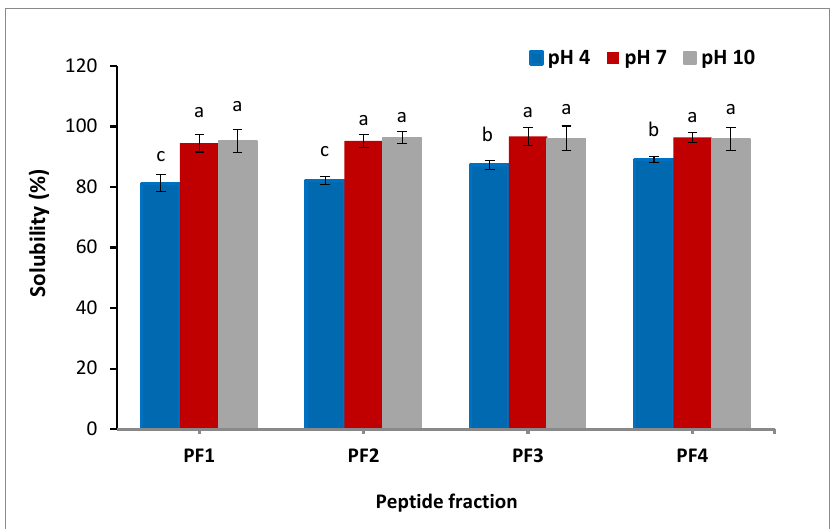
Figure 1. Solubility of the isolated peptide fractions at pH 4.0, 7.0, and 10.0. * Results are illustrated as means ± SD and values within each column with the different letters are significantly different ( p < 0.05).